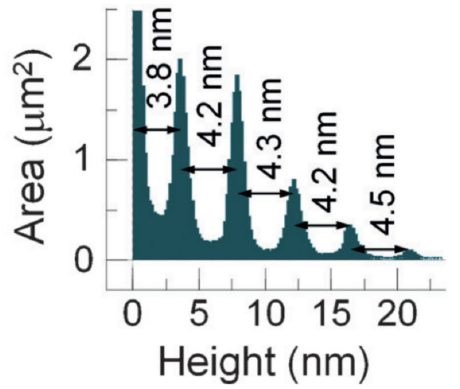
Figure 3. Height and size of antimonene prepared. Reprinted with permission from Ref. [43]. Copyright 2016, John Wiley and Sons.